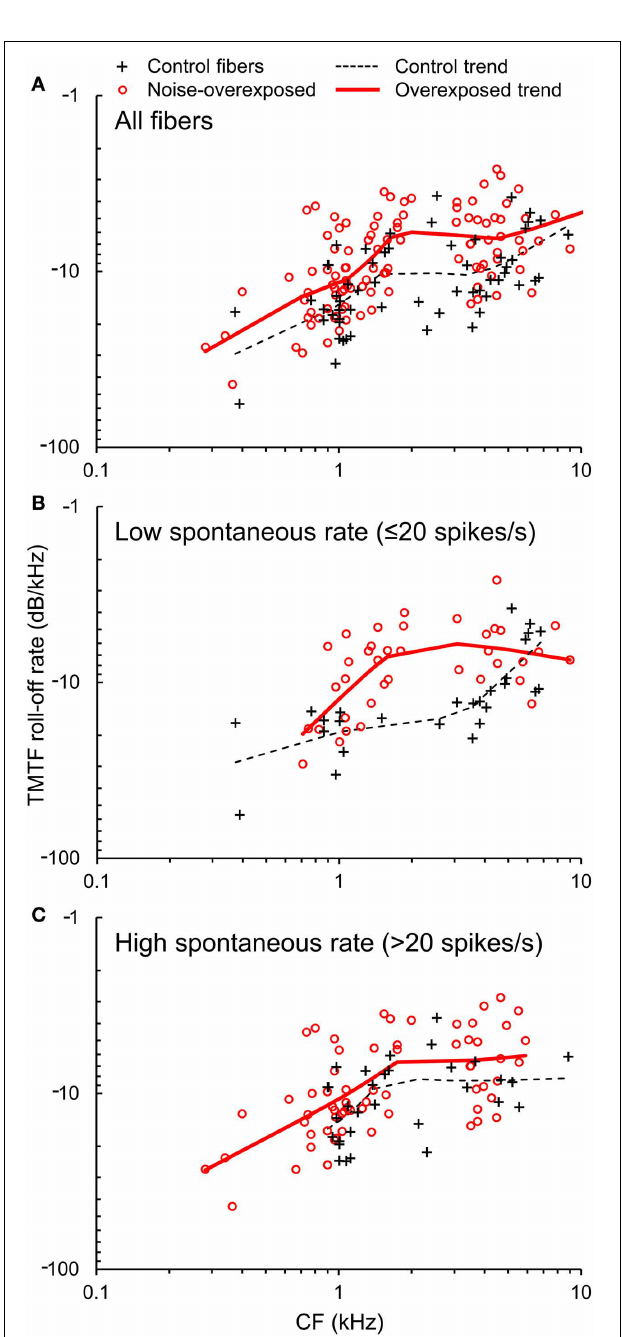
FIGURE 5 | TMTF roll-off rate. (A) The roll-off rate of TMTFs plotted as a function of CF in normal hearing and noise-overexposed auditory-nerve fibers. Data from subpopulations of fibers with low and high spontaneous rate are shown in panels (B) and (C) . Trend lines are based on local regression analyses. Roll-off rate was 30% slower (less negative) in noise-overexposed fibers than in normal-hearing controls.